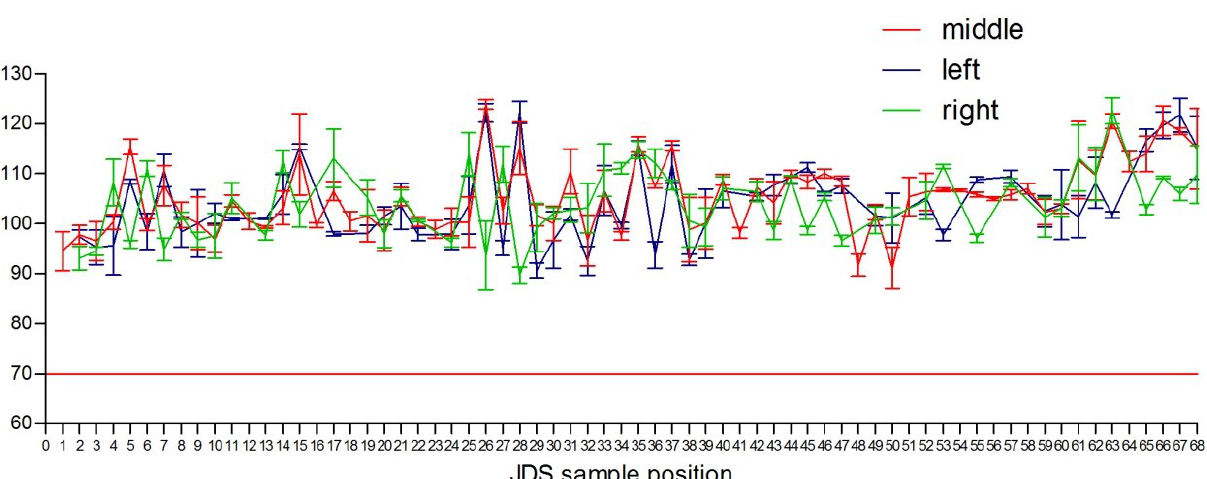
Figure 4. Values of the MTS results of the River Danube sampling points (x-axis). The y-axis represents percentage of viability compared to the control (deionized water, was set as 100%). The red line at 70% represents the limit value for an inhibition of growth caused by a toxic compound or a combination of